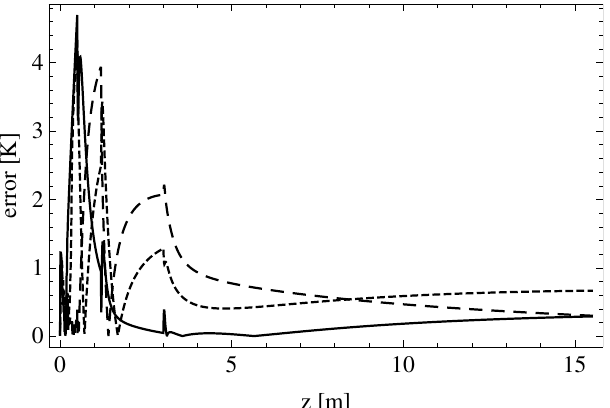
Figure 5. Absolute error of temperature reconstruction in the control points for measurements read at every 0.01m and burdened by 5% error (one step